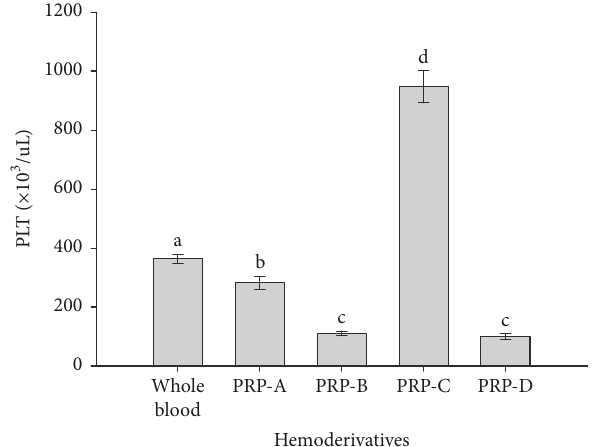
Figure 2: Mean ( ± standard deviations [SD]) of platelet (PLT) concentration ( × 10 3 / 𝜇 L) in whole blood and four PRP fractions (A, B, C, and D). a–d: different lowercase letters denote significant differences by the Tukey test ( 𝑝 = 0.001 ).